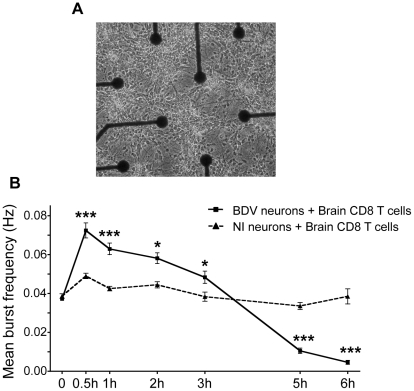
Analysis of electrical properties of neurons upon contact with brain CD8 T cells.(A) Representative view of cortical neurons cultured in an MEA dish. Electrodes are spaced by 200 µm; electrode diameter is 30 µm. Original magnification, X50. (B) Quantitative analysis of the mean burst frequency for non-infected (NI) neurons and BDV-infected neurons upon coculture with brain CD8 T cells (at a ratio of 1∶1). The mean burst frequency was first calculated under spontaneous conditions and at various times after the beginning of coculture. For each condition, data were acquired from 100 to 460 electrodes, from five independent experiments. Values are expressed as means ± sem *, p<0.05; ***, p<0.001 by unpaired Student's t-test.